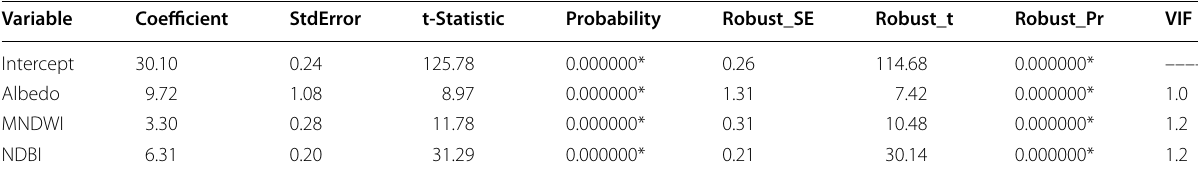
Table 9 Table Summary of ordinary least square regression of LST (dependent variable) and Albedo, MNDWI, and NDBI (independent variables)